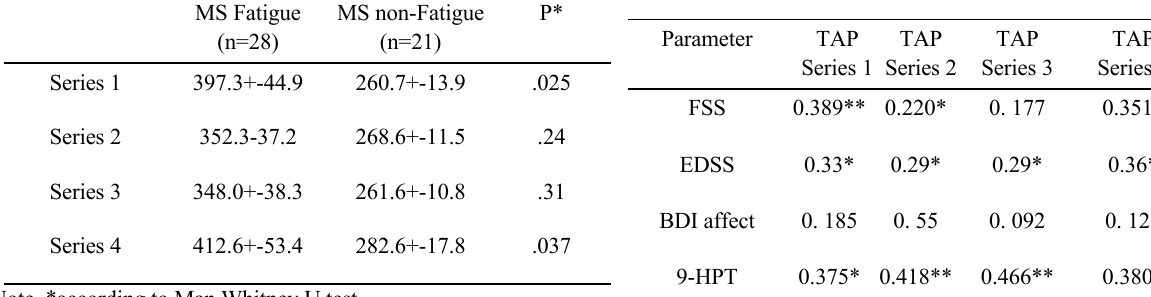
Table 4. TAP alertness in MS patients with and without fatigue Table 5. Correlations ( Spearman Rho) TAP and SDMT, EDSS, BDIaff, 9-HPT.